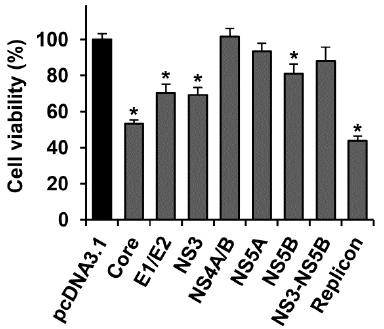
Figure 1. Several hepatitis C virus (HCV) proteins hamper growth/viability of Huh7.5 cells. The cells, transfected with plasmids encoding HCV proteins, were counted 72 h posttransfection by microscopy visualization, and the values were normalized to the number of cells transfected with the empty pcDNA3.1(+) vector. The data are presented as means ± standard error of the mean (SEM) of eight measurements done in three independent experiments. * p < 0.05 vs. cells transfected with pcDNA3.1(+) vector (black bar).